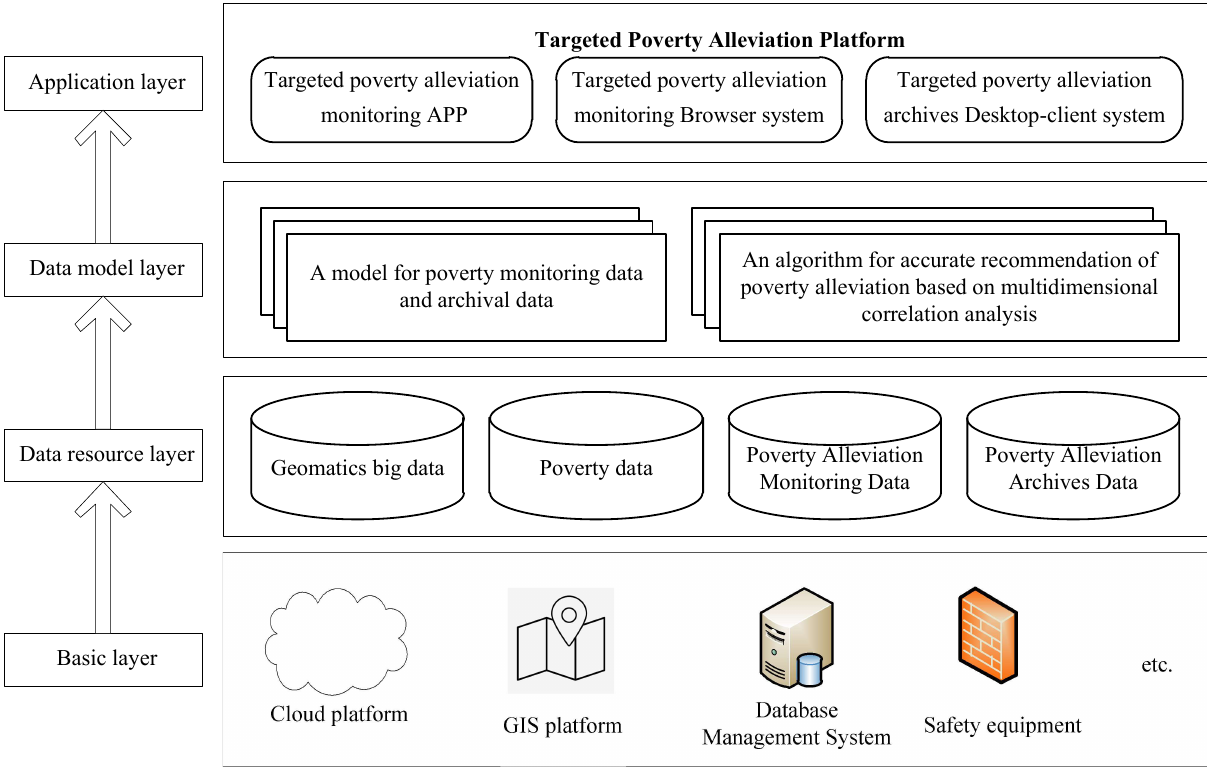
Figure 1. Smart poverty alleviation architecture